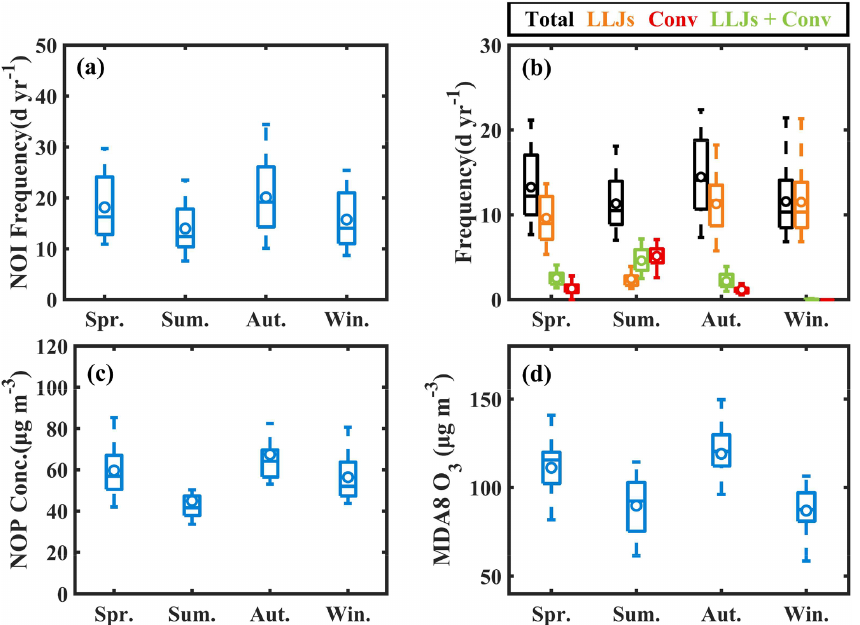
Figure 4. Seasonal variation of (a) frequency of NOI events; (b) frequency of total downdrafts (black), LLJs (orange), LLJs+Conv (green), and Conv (red) that can induce NOI events; (c) NOP concentrations; and (d) MDA8 O 3 concentrations in the PRD region during 2006–2019. The error bars indicate the range of deviations for the 16 air quality sites.